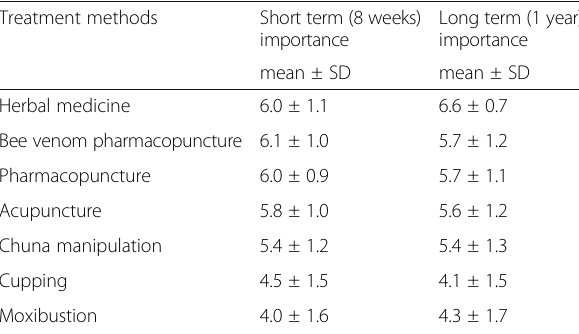
Table 3 Influence by factor in prognosis determination